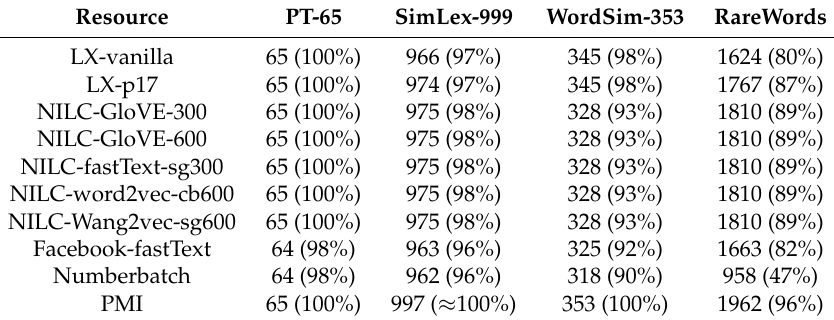
Table 11. Coverage of each dataset by each distributional model.